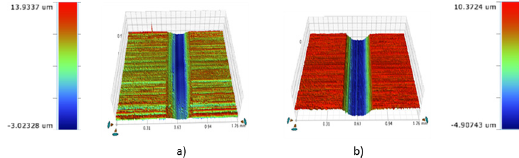
Figure 11: Profilometry results for the conventional quenching sample in a) dry condition and b) corrosive medium.